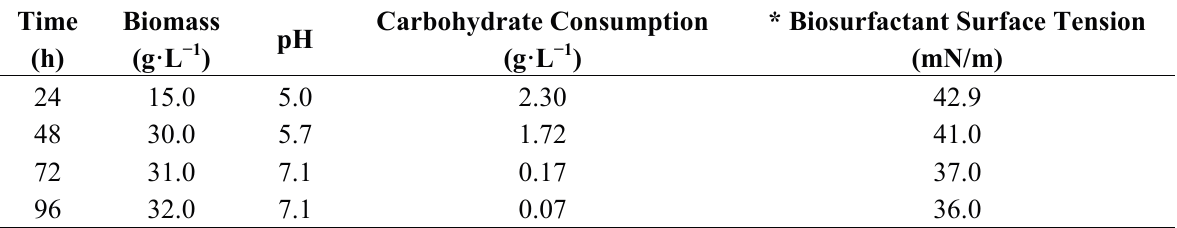
Table 1. Time-course of growth, pH, carbohydrate consumption and